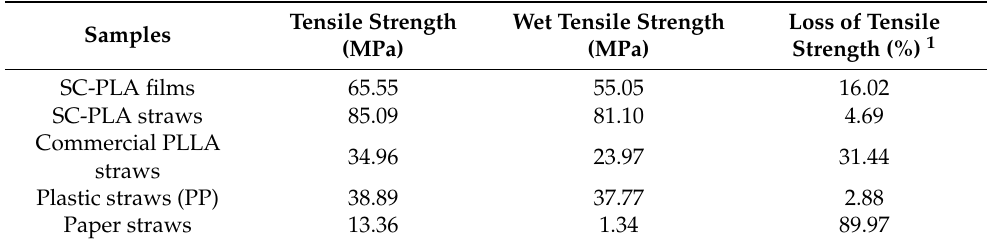
Table 2. Comparison of average tensile strength and loss of tensile strength of straws exposed to 100 ◦ C hot water for 10